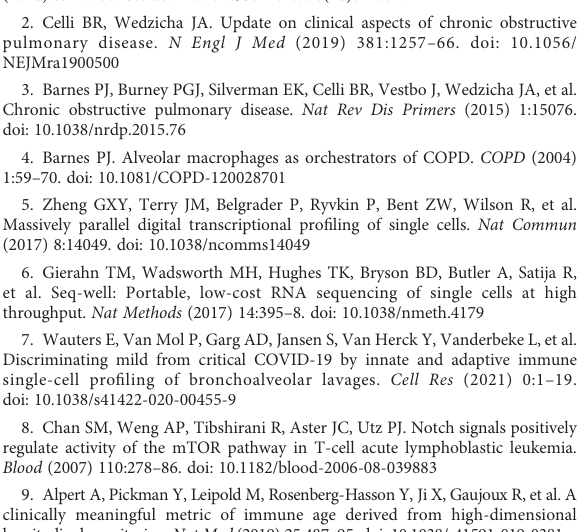
SUPPLEMENTARY FIGURE 6 Modeling the association of blood monocytes and BALF macrophages (related to ). (A) UMAP of embedded macrophages/monocytes from BALF and blood monocytes with coloring according to the cell types derived from the combined labels. The dendrogram on the right side illustrates the transcriptional relationship between the macrophage subtypes and shows how severalsubtypesweresummarized inthe combinedlabels. (B) Projection of computed RNA velocity vectors onto the UMAP of the embedded data. BALF = bronchoalveolar lavage fl uid; mono = monocyte; M Ф = macrophage; proliferat. = proliferating. SUPPLEMENTARY FIGURE 7 Instructions for accessing the COPD Seq-Well dataset and scripts via the FASTGenomics